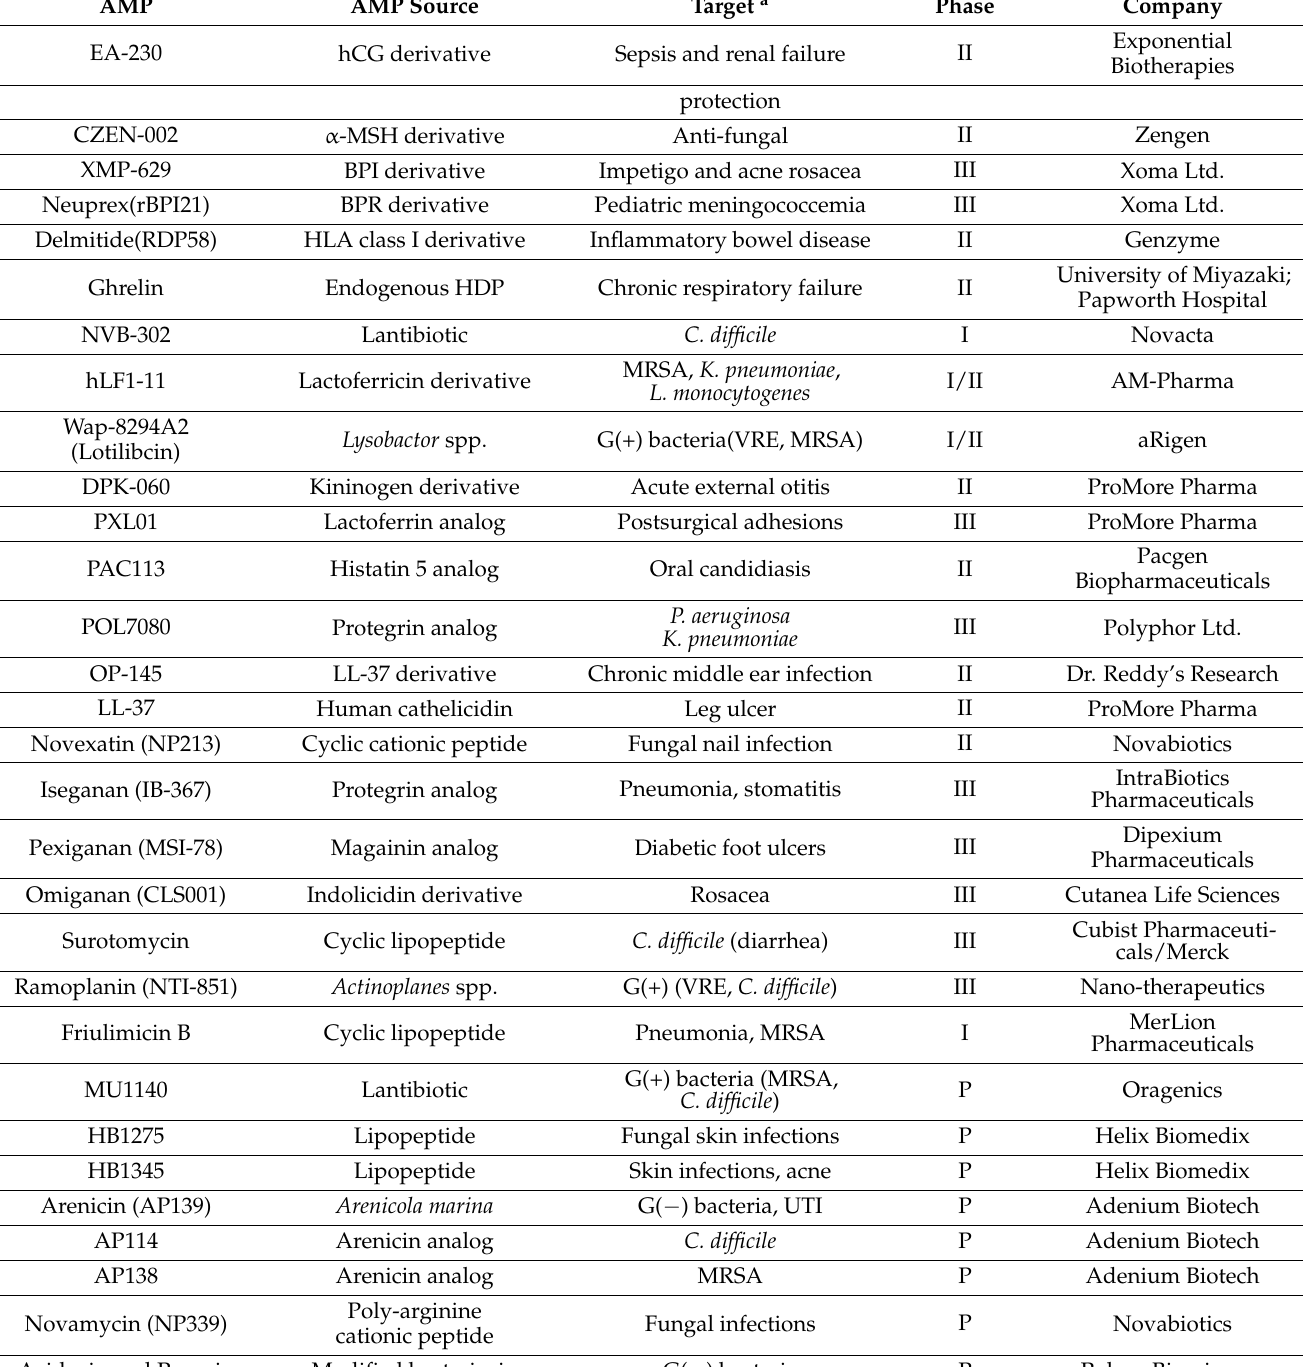
Table 1. AMPs in clinical trials (phase I-III) and preclinical trials (2019). Data collected from